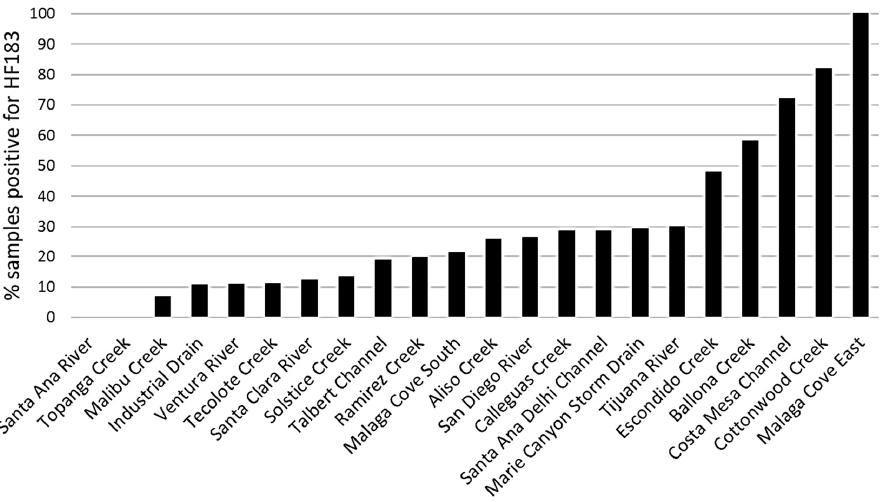
Figure 2. Frequency of HF183 detection at the 22 sites in summer dry weather. Frequency of HF183 detection is defined as % samples that are positive for HF183, and a sample is deemed HF183 positive if HF183 amplified in any of the three qPCR